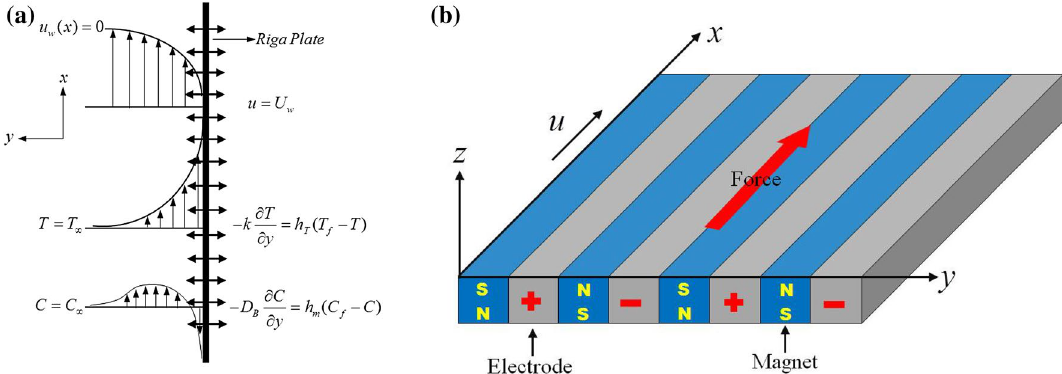
Figure 1. ( a ) The fluid flow geometry. ( b ) Lorentz force induced Riga